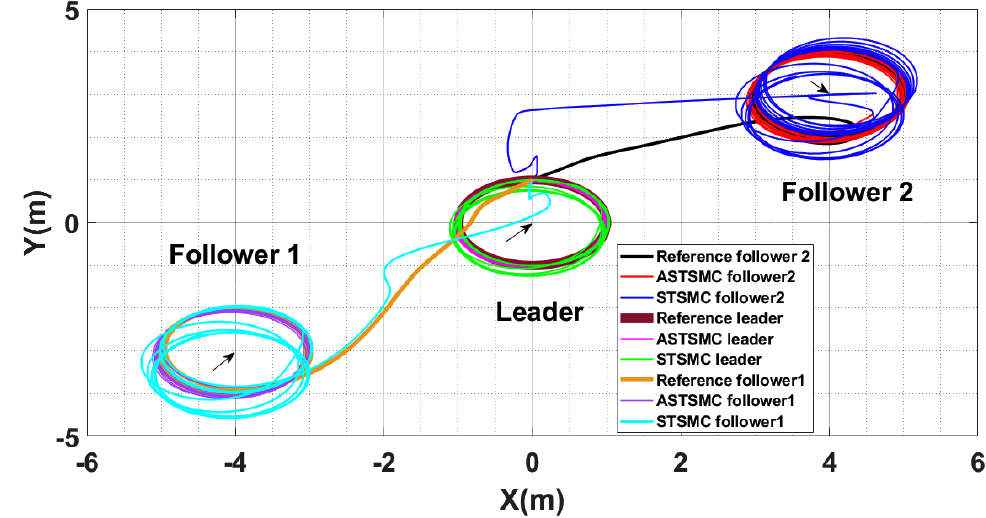
Figure 8. XY Leader-followers trajectory tracking comparison under wind disturbance. To compare the trajectory tracking performance of the leader followers UAV quanti- tatively, the X and Y trajectories are individually plotted against time and the results